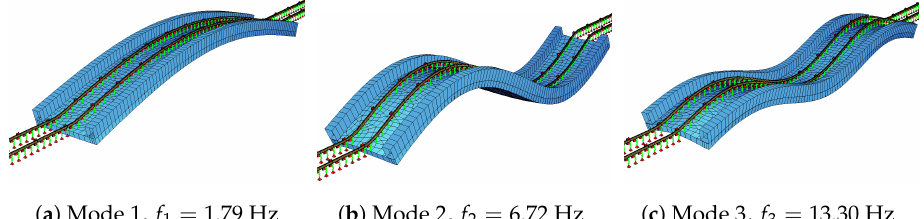
Figure 7. Mode shapes of the